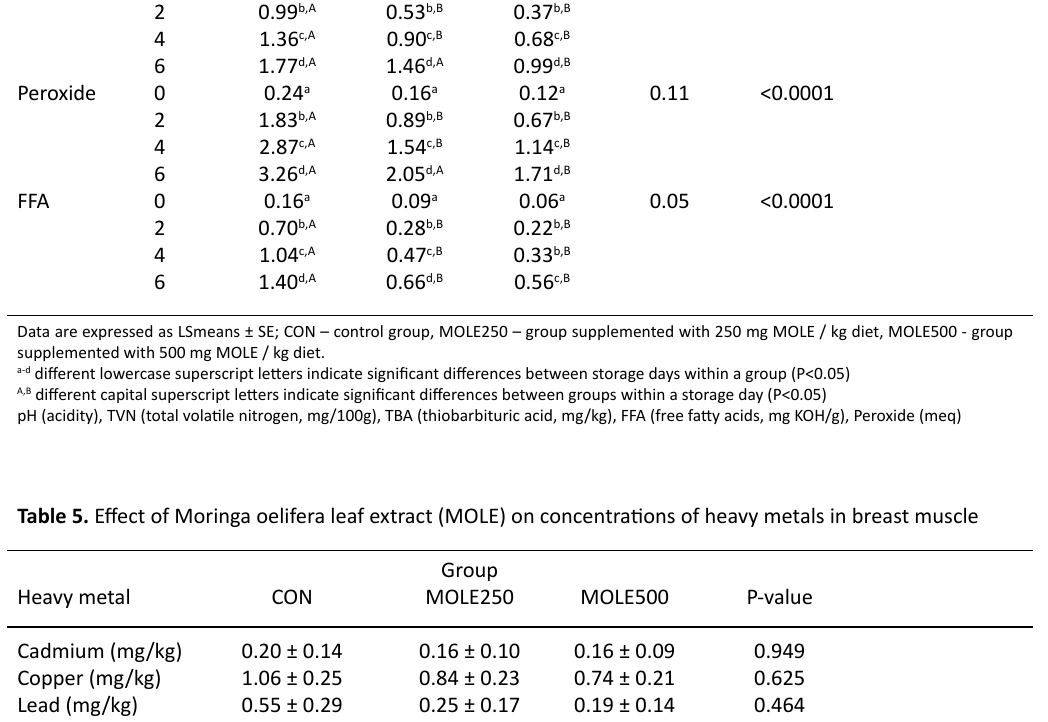
Table 5. Effect of Moringa oelifera leaf extract (MOLE) on concentrations of heavy metals in breast muscle Heavy metal CON MOLE250 MOLE500 P-value Cadmium (mg/kg) Lead